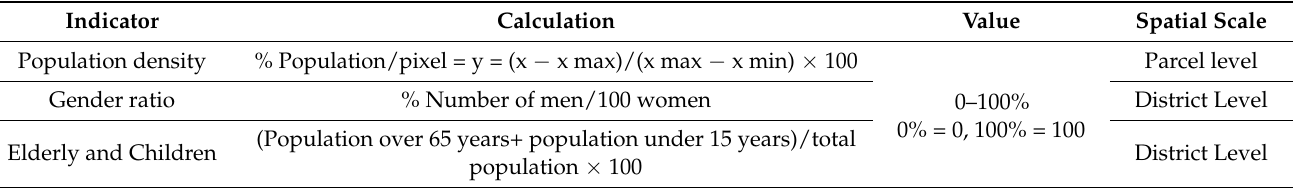
Table 2. Vulnerability Indicator